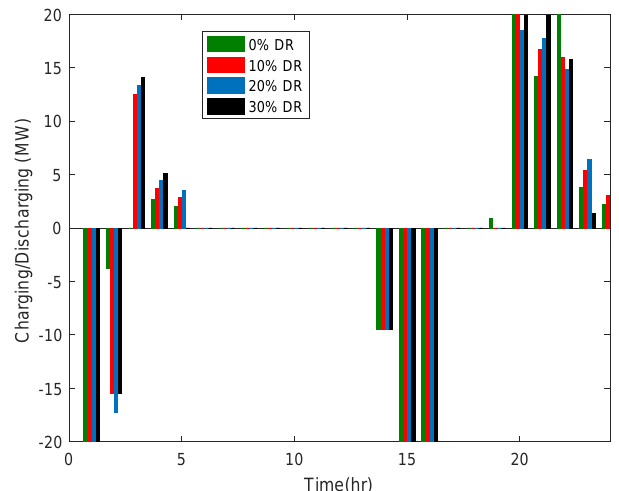
Figure 12. The charging/discharging